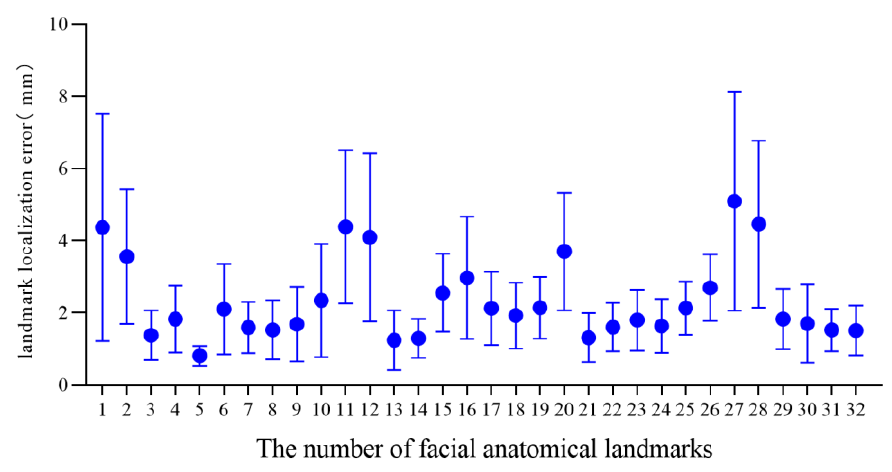
Figure 5. Landmark localization error for each facial anatomical landmark in the TH group.